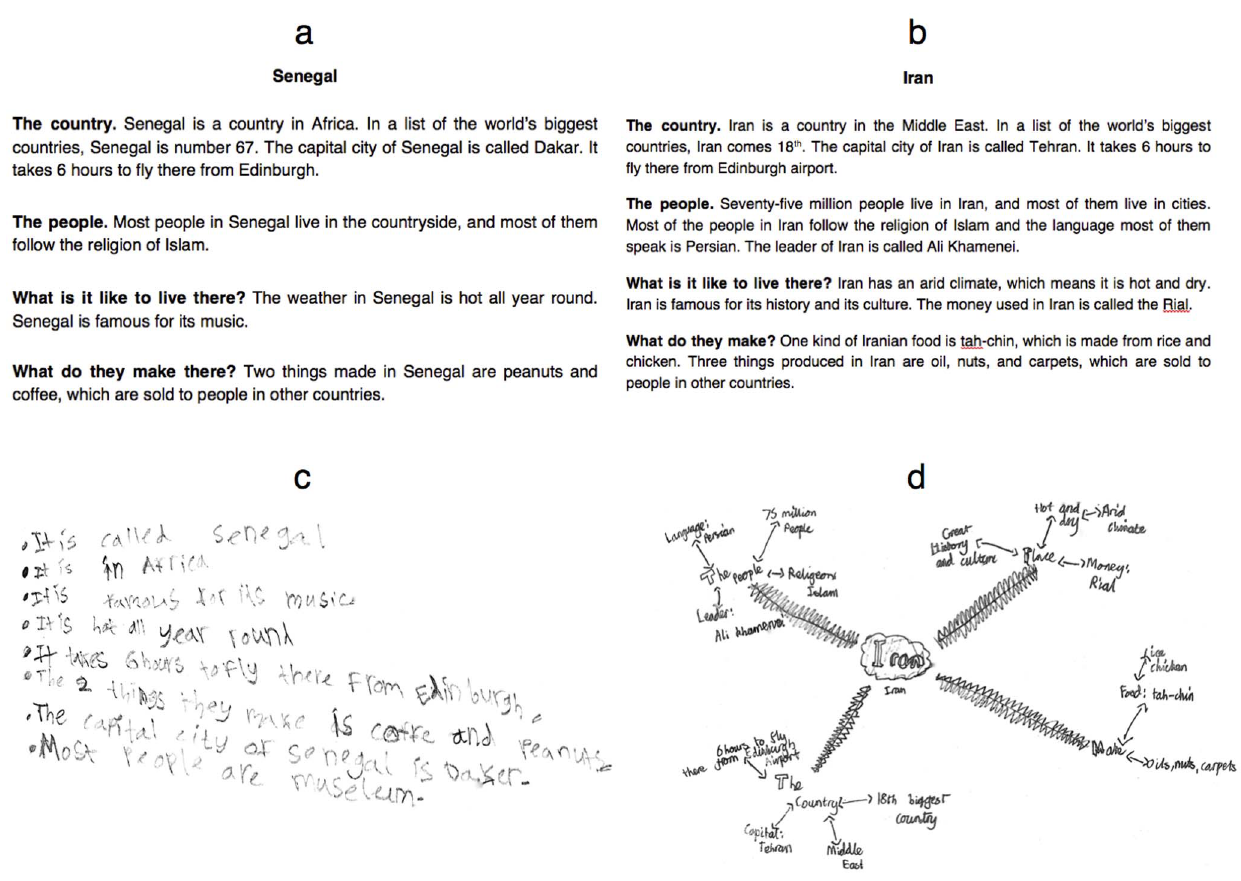
Figure 1. Example factsheets for (a) Primary 4 and (b) Primary 7 in Experiment 2; (c) example notes from one Primary 4 child in Experiment 2 and (d) an example mind map from one Primary 7 child in Experiment 2.